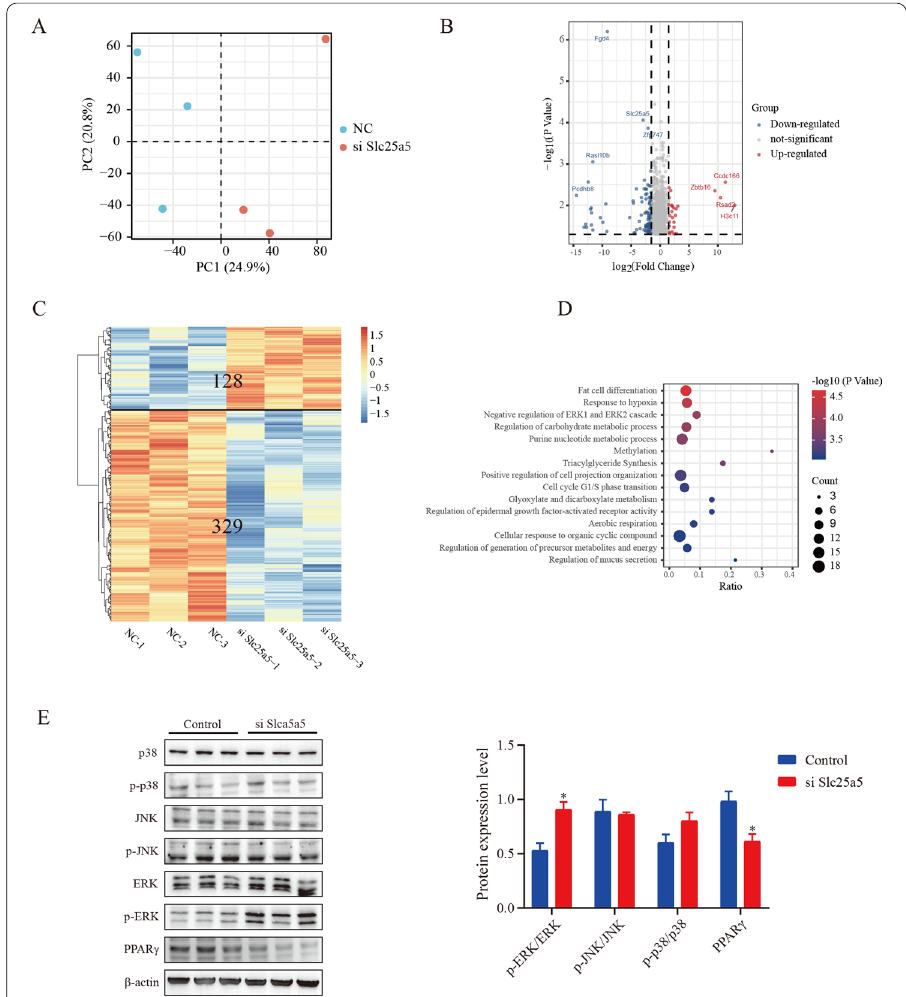
Fig. 4 Transcriptomics analysis implicates ERK pathway as a target of Slc25a5 . After adipogenic differentiation, OP9 cells with or without Slc25a5 knockdown were collected, and a transcriptome analysis was performed. A PCA score plot showing clear clusters in each group. B Scatterplot of DEGs between the control and Slc25a5 -knockdown cells (fold change control and Slc25a5 -knockdown cells. D GO analysis of downregulated DEGs. E Protein levels of ERK, p-ERK, P38, p-P38, JNK, p-JNK, and PPARγ were measured by western blot analysis. The values are the mean ( n 3). * P < 0.05 versus =